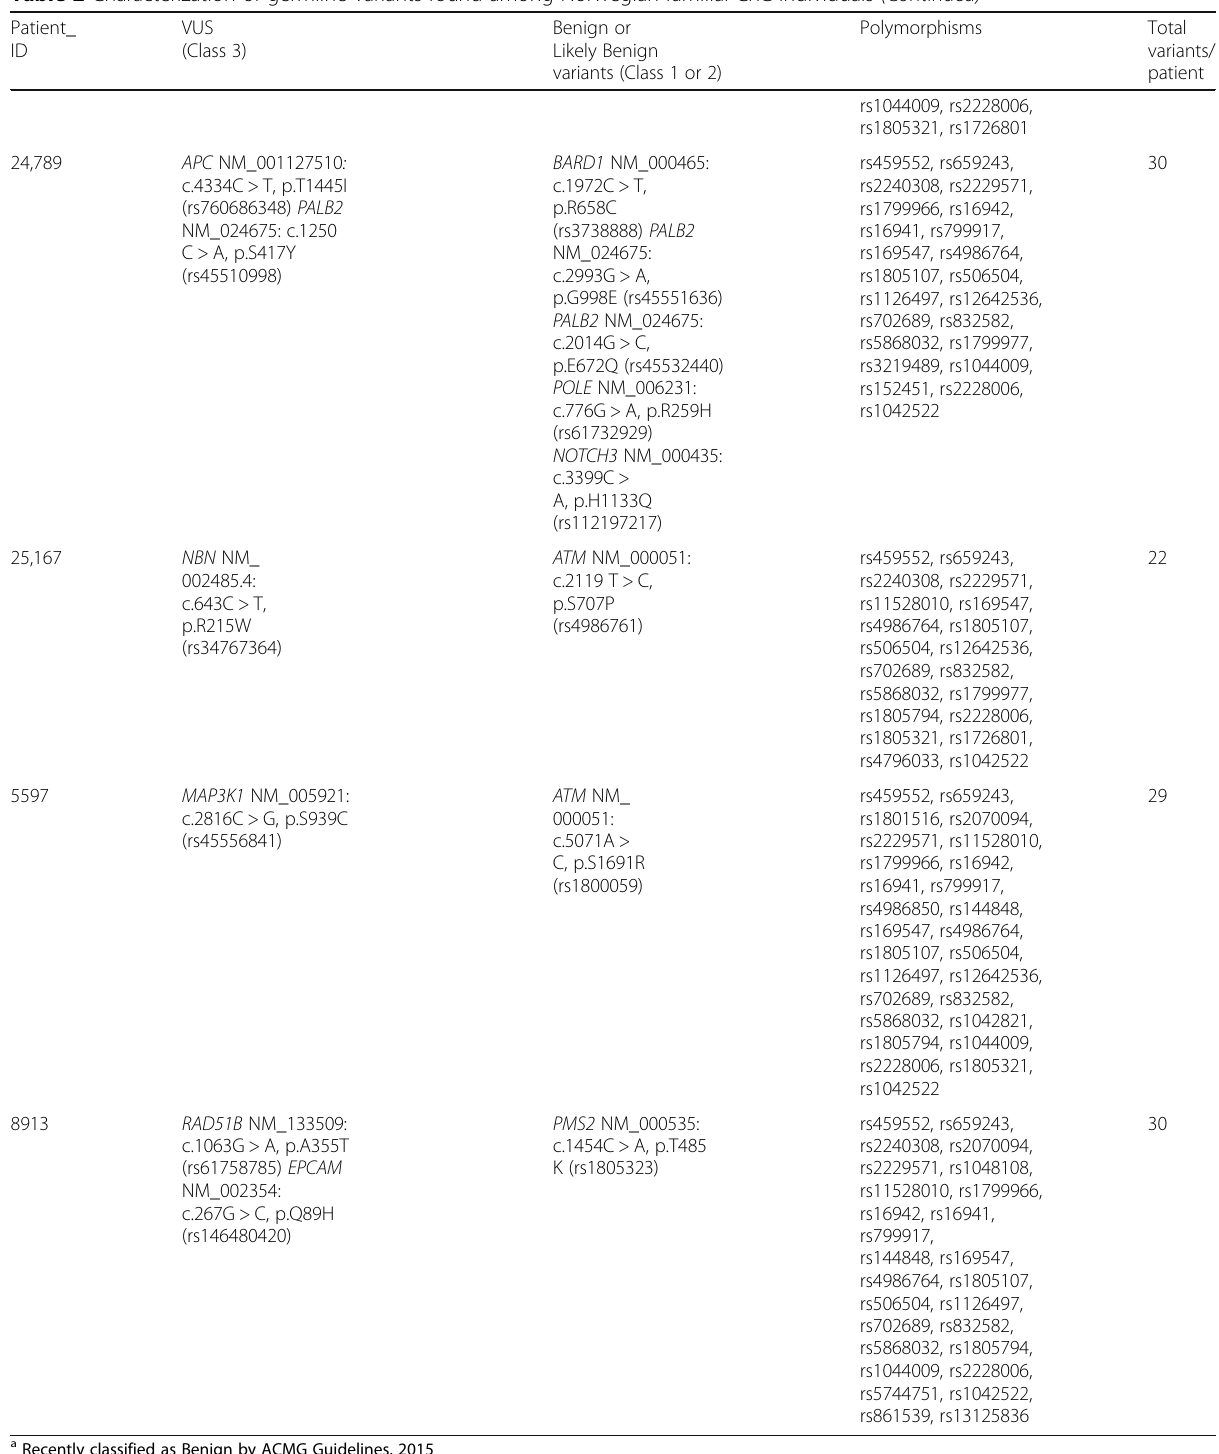
Table 2 Characterization of germline variants found among Norwegian familial CRC individuals